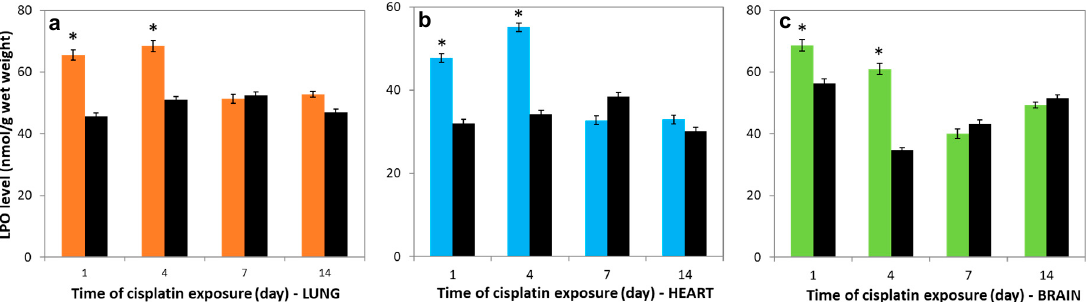
Figure 4. Lipid peroxidation (LPO) levels in ( a ) lung, ( b ) heart and ( c ) brain tissues over time. Lung ( ⎯ ⎯ ), heart ( ⎯ ⎯ ), and brain ( ⎯ ⎯ ) tissues of treatment group, and controls ( ⎯ ⎯ ). Results are expressed as mean ± SD ( n = 6). *Significantly different ( p < 0.05) from control.